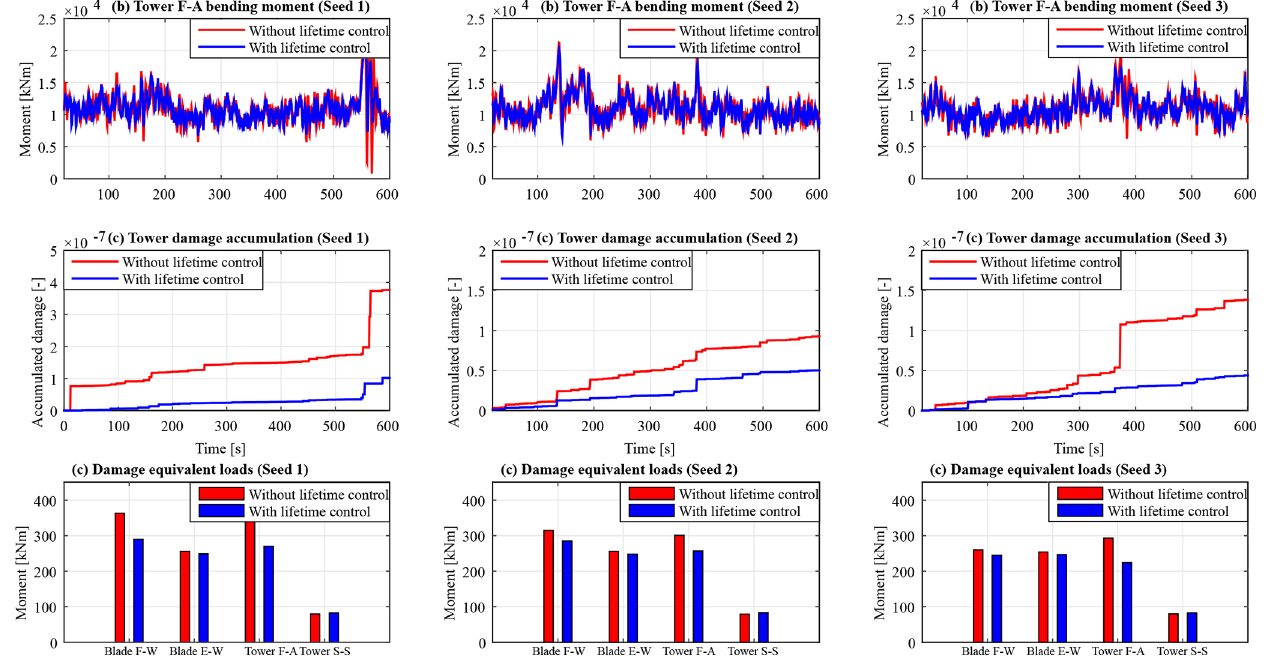
Figure 11. Tower fatigue load mitigation and DEL analysis for 14ms − 1